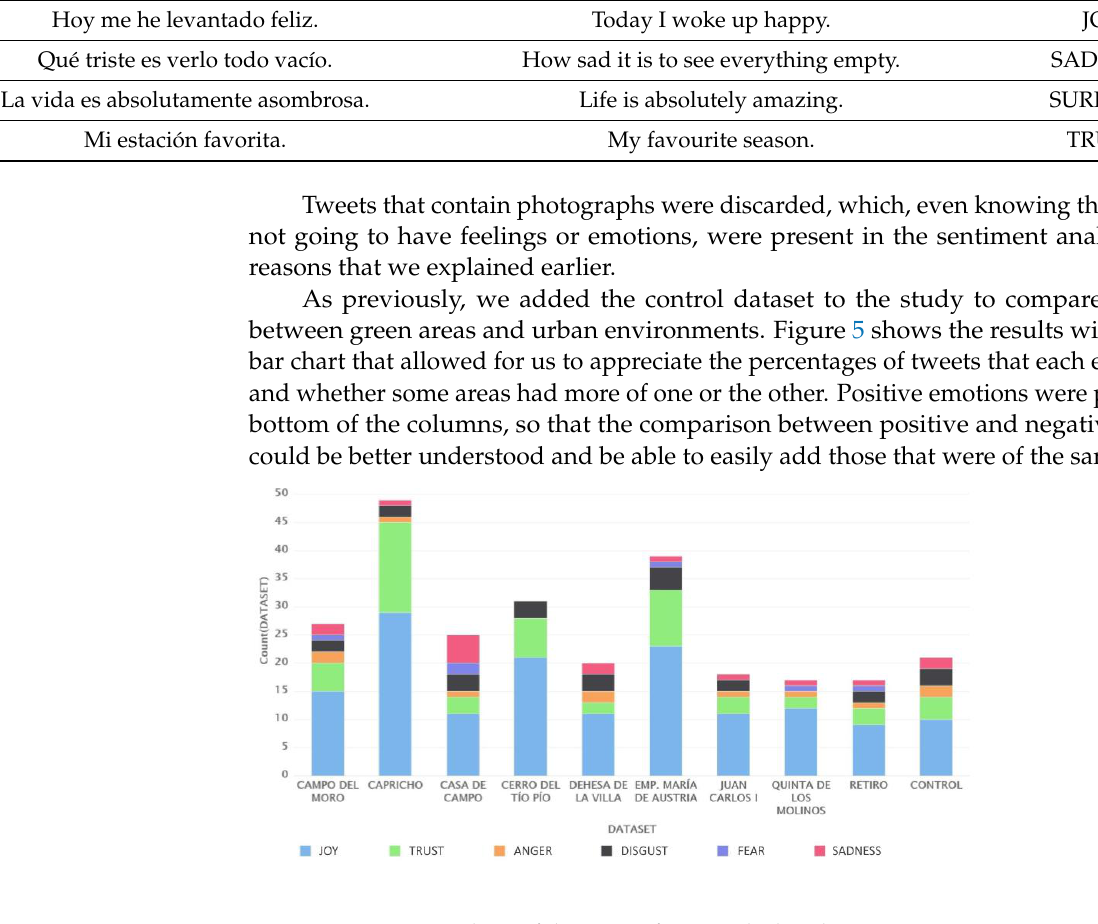
Figure 5. Emotion analysis of the tweets from Madrid parks in